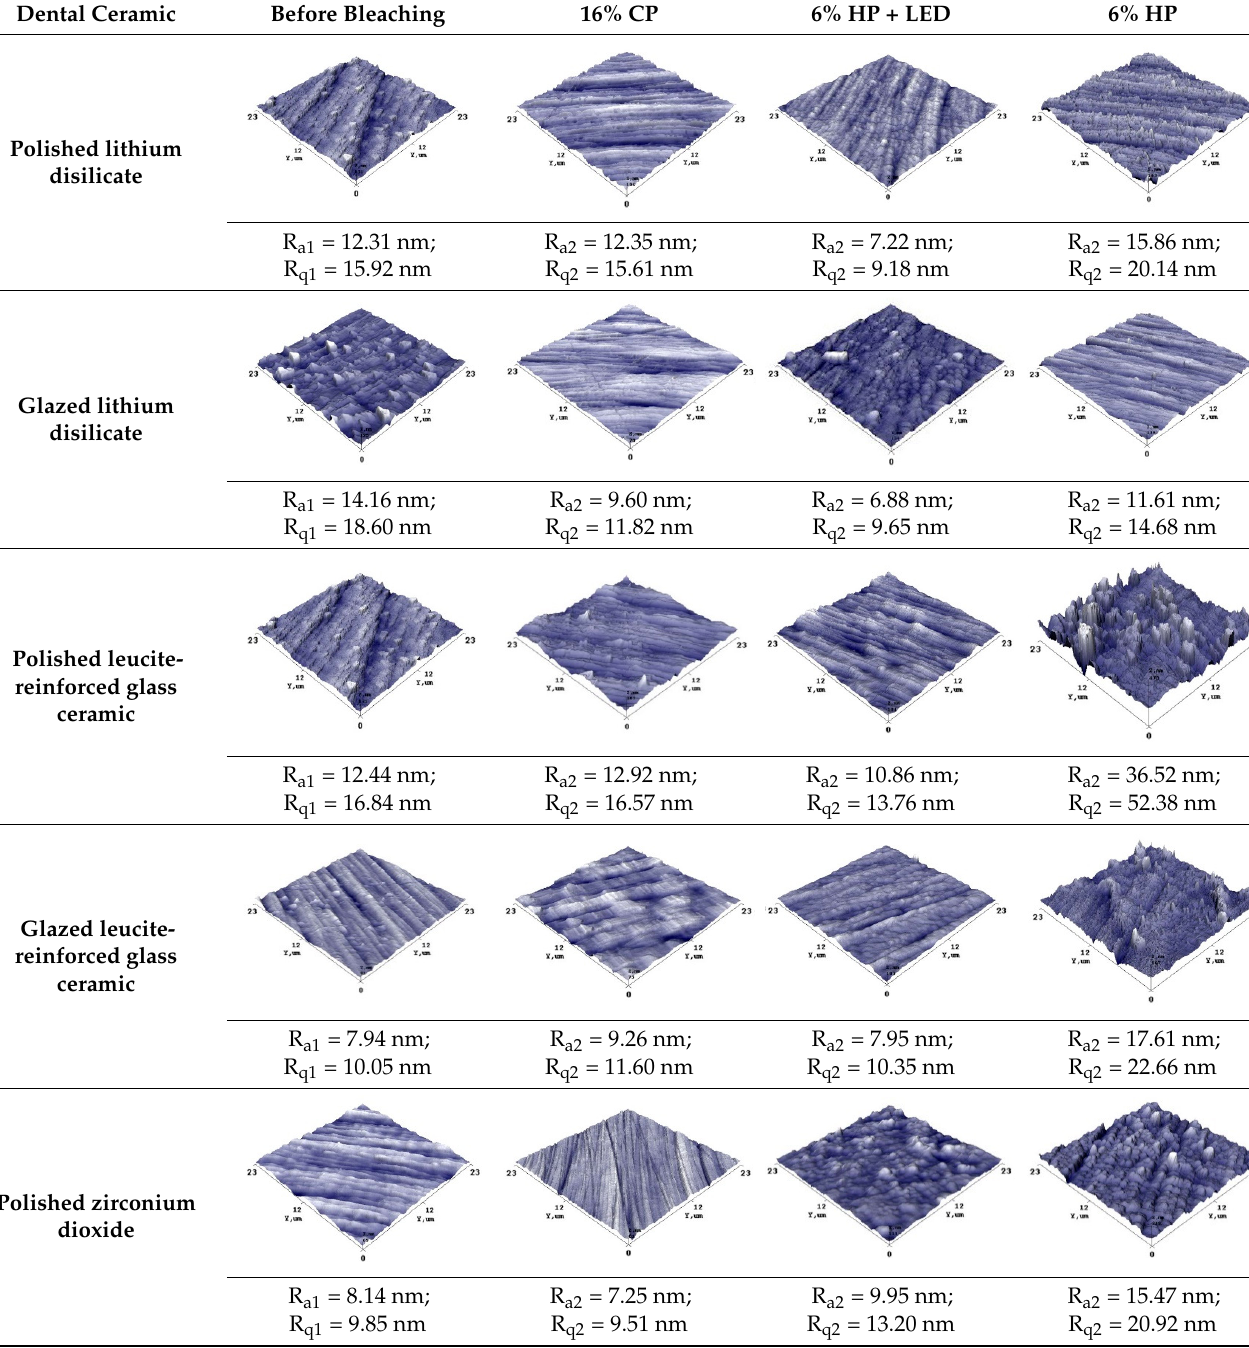
Table 3. Mean surface roughness values of dental ceramics before and after bleaching with different bleaching